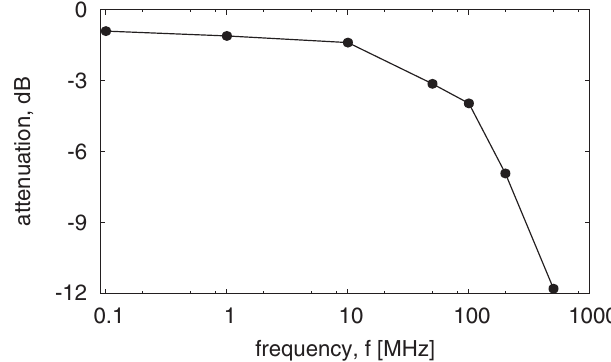
FIG. 14. Bandwidth calibration of the electron detector. The signal is reasonable flat and attenuated by less than 3 dB up to about 50